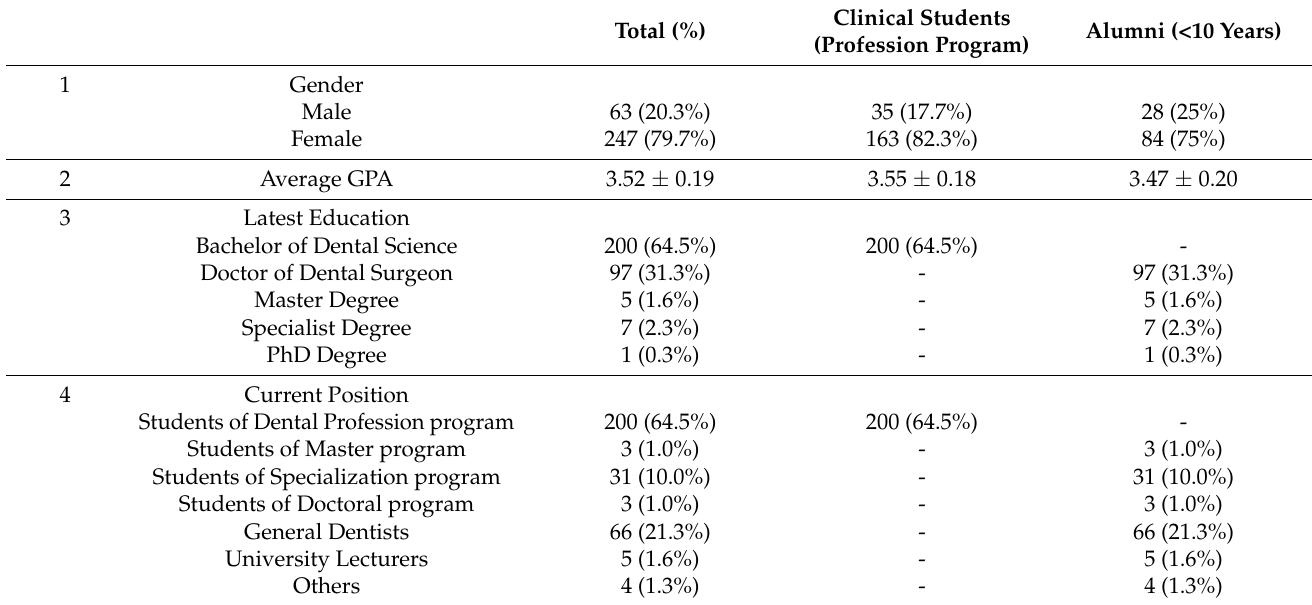
Table 1. General Information.